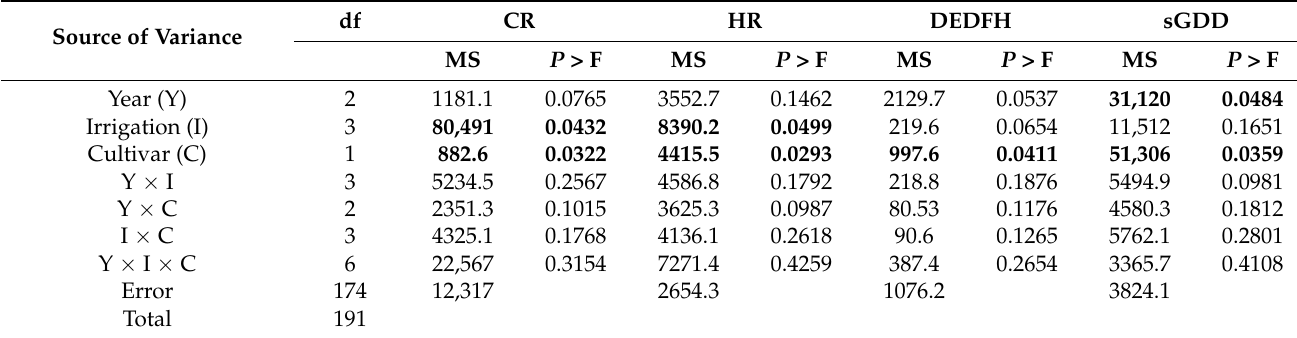
Table 3. The monthly irrigated water (L tree − 1 ) and overall annual irrigated water (L tree − 1 , m 3 ha − 1 ) for the four deficit irrigation treatments (control, RDIm, RDIs, and CDI) of apricot trees at Wadi El Natrun, El Beheira Governorate, Egypt (2016–2018). Bold figures indicate significant differences at P < 0.05. Explanations for Control, RDIm, RDIs and CDI are given in Figure 2.